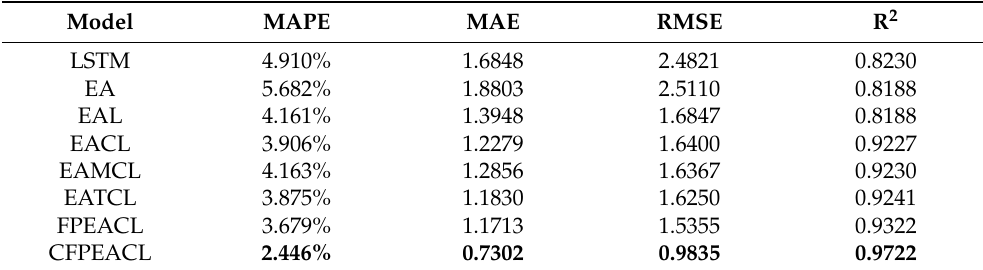
Figure 10. Comparison of final annual monthly load forecasting results between CFPEACL and other models. Table 7. The comparison between CFPEACL and other models of final annual monthly load forecasting results.